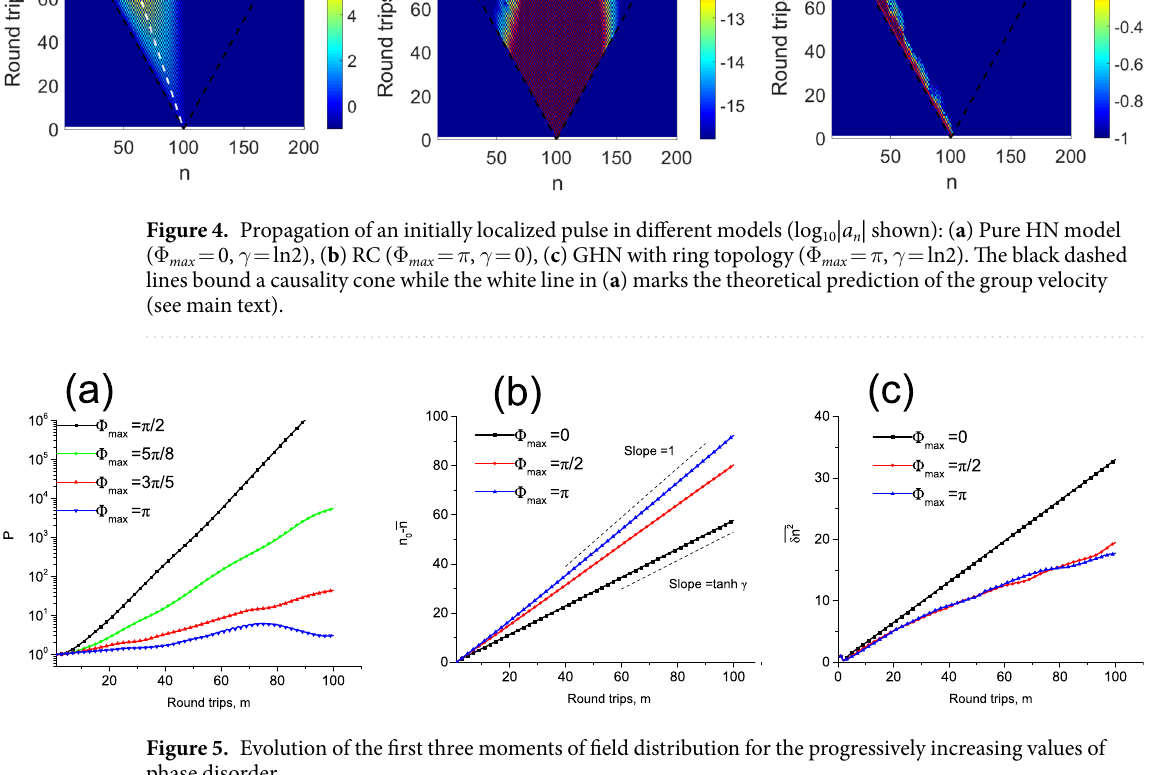
Figure 5. Evolution of the first three moments of field distribution for the progressively increasing values of phase